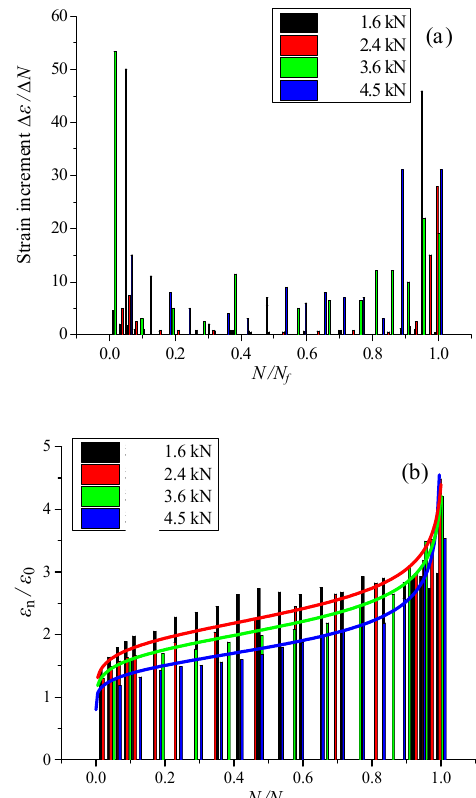
Figure 16. Evolution of strain characteristics for different dynamic stress: ( a ) strain increment, ( b ) ε n / ε 0 .